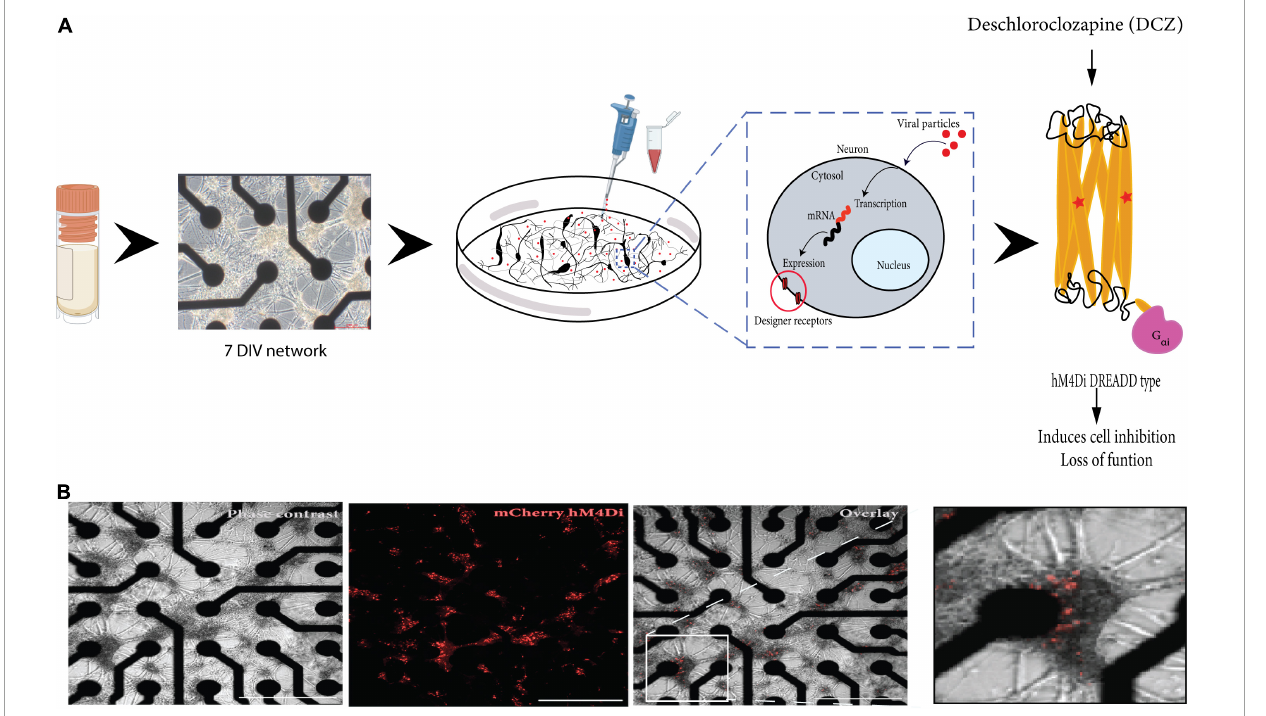
FIGURE1 Illustration of the workflow of the study. (A) Cryopreserved cortical neurons were thawed and seeded on precoated microelectrode arrays (MEAs) until 7 DIV (scale bar = 200 µ m). Neurons grow on top of the electrodes (black) and connect with each other across the surface. The designer receptors exclusively activated by designer drug (DREADD) protein is encoded in a replication deficient adeno-associated viral vector (AAV2/1) that is targeted for cytoplasmic gene delivery, thus circumventing genomic integration. The vector was added directly to the neurons in culture (on the MEA). The vector codes for the cell-specific promoter CaMKlla so that mRNA transcription is targeted specifically at excitatory neurons which will be the cells that express the designer receptors. The designed DREADD hM4Di receptor has mutations at two points, which results in the receptor being insensitive to its endogenous agonist and neurotransmitter acetylcholine and instead respond only to a physiologically inert exogenous molecule (designer drug) such as deschloroclozapine (DCZ). When DCZ binds, the hM4DiR preferentially signals through the Gai/o subset of G-protein to inhibit adenylate cyclase and downstream cyclic adenosine monophosphate (cAMP) production, causing neuronal hyperpolarization and induces loss of cellular activity. (B) In vitro neural network on MEA at 12 days post adding the virus. DREADDs expression was confirmed without immunocytochemistry based on strong mCherry fluorescent expression in the network. Scale bar = 1250 µ m.